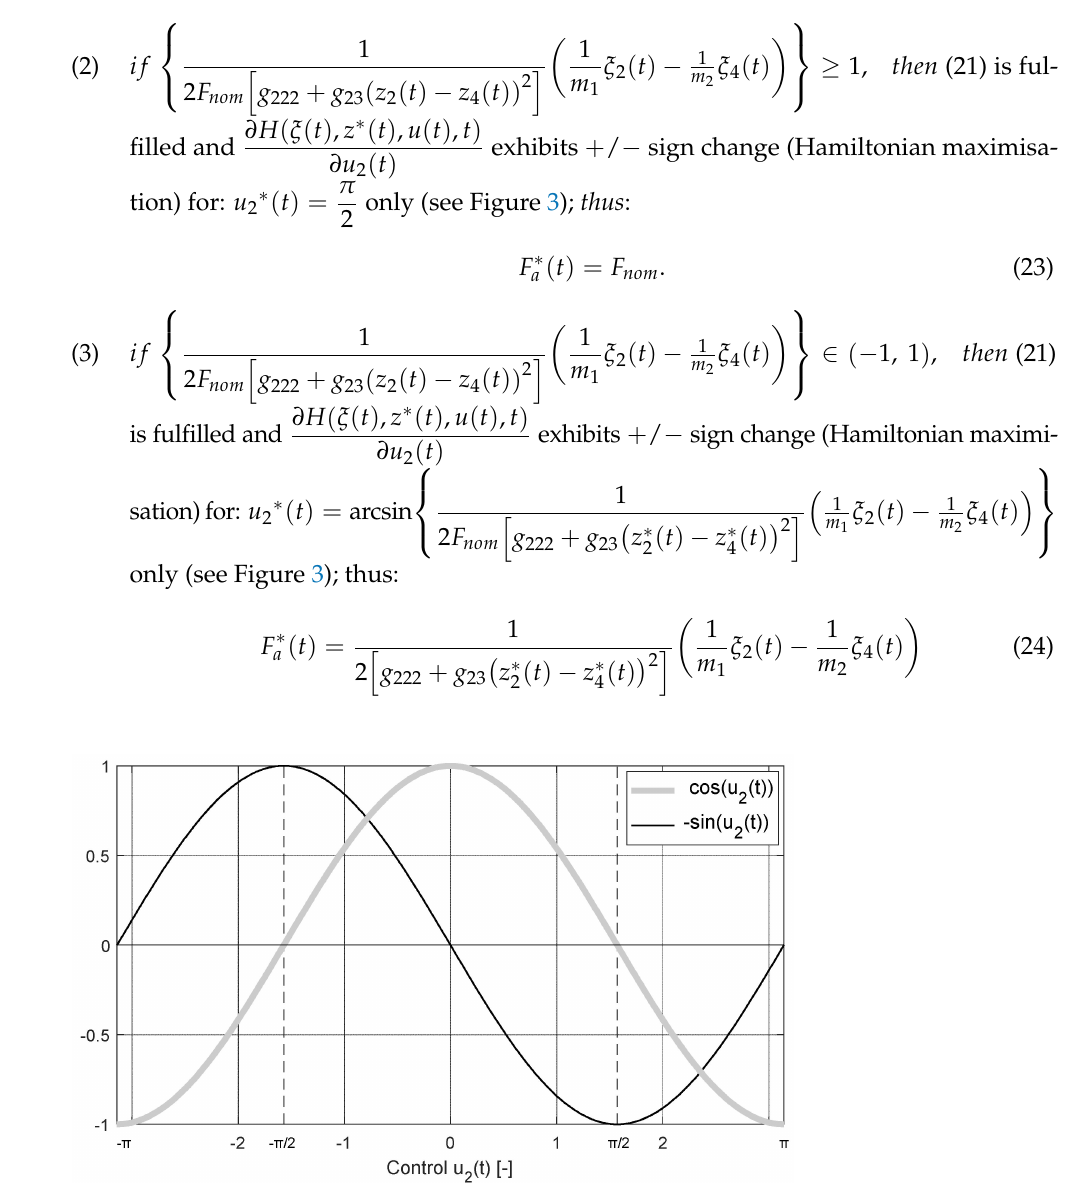
Figure 3. Hamiltonian derivative (21) sign